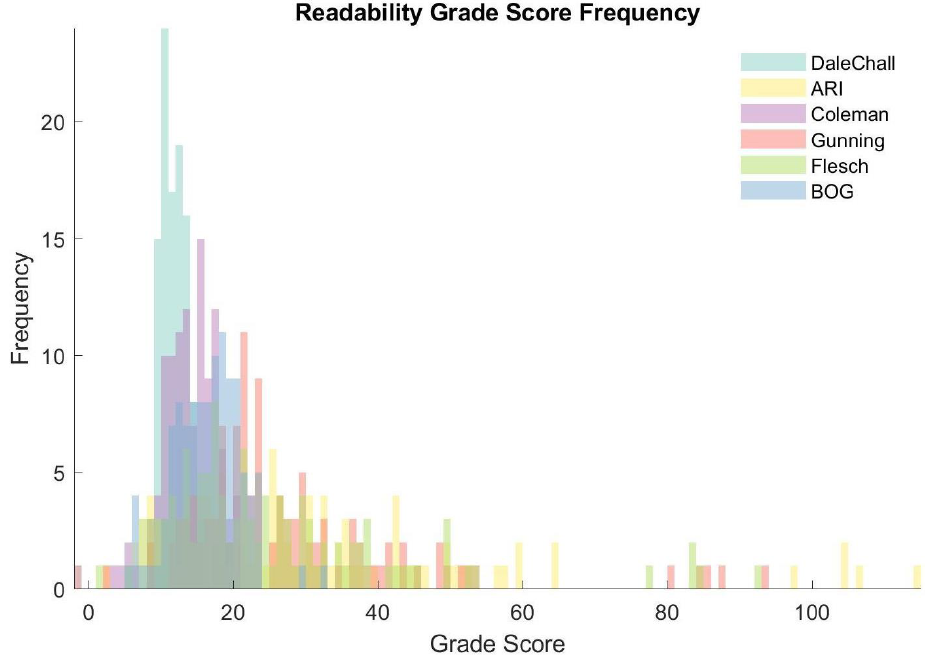
Figure 6. Frequency distributions for the readability metrics across all 112 nodes/questions of the digital